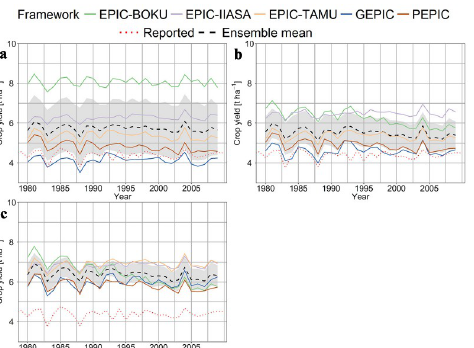
Fig 2. Global average area-weighted maize yield estimates of five EPIC-based GGCMs. (a) default, (b) fully harmonized (fullharm), and (c) fully harmonized with sufficient nutrient supply (harm-suffN) management scenario